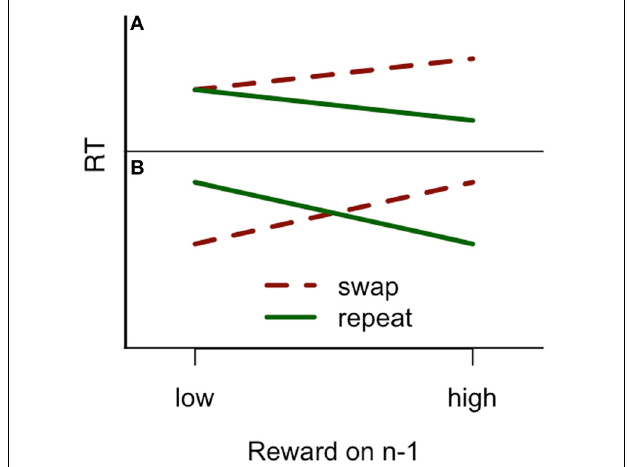
FIGURE 1 | (A) The reward priming pattern reported in Hickey et al. (2010a), where low reward did not affect the subsequent trial, but a high reward did so contingent on whether color was repeated or not. (B) The reward priming pattern reported in Hickey et al. (2010b, 2011), where both high and low reward affected response times, contingent on color repetition, but in the opposite ways, as if a target previously associated with high reward was subsequently highly valued, but a target previously associated with low reward was subsequently devalued. The figure does not represent actual data and is only for illustrative purposes. See Hickey et al. (2010a,b, 2011) for details on their